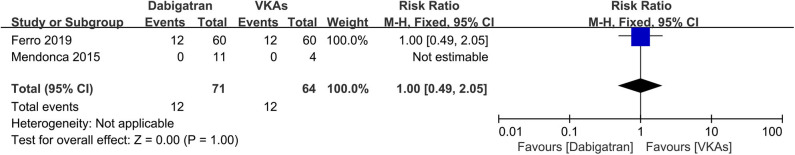
Bleeding events between dabigatran and VKAs.